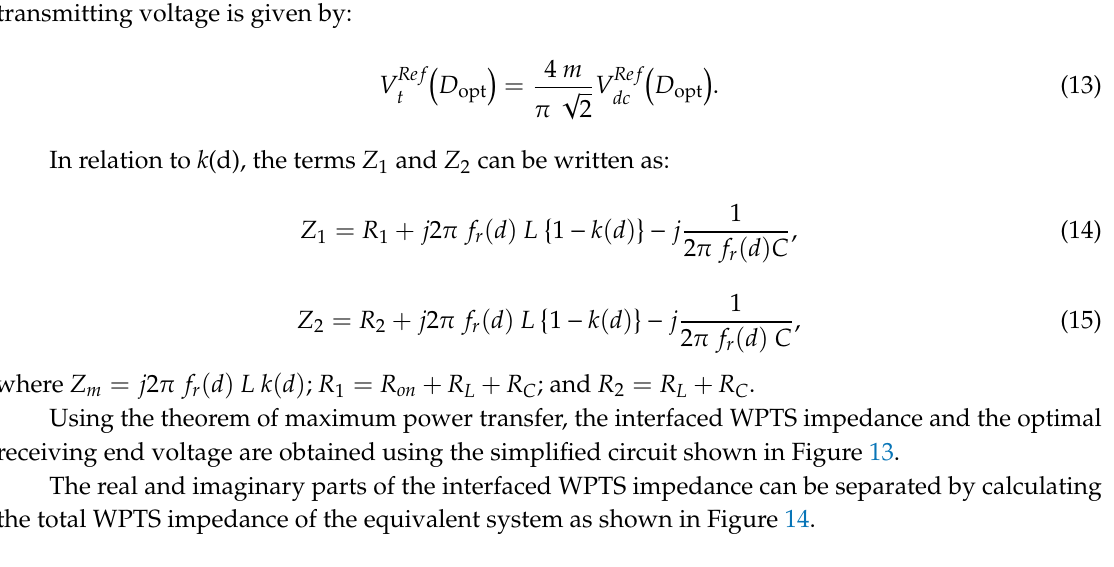
Figure 13. Equivalent WPTS.